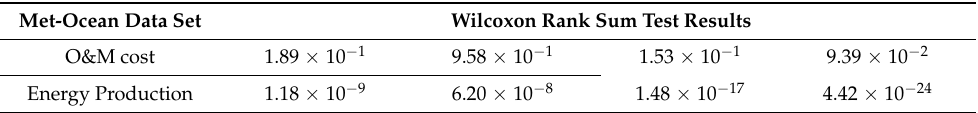
Figure 6. The lifetime O&M cost distributions resulted from the representative met-ocean reference year and twenty-year met-ocean data for ( a ) 5 turbines, ( b ) 10 turbines, ( c ) 20 turbines, ( d ) 30 tur- bines. Table 6. Wilcoxon rank sum test results for lifetime O&M cost and lifetime energy